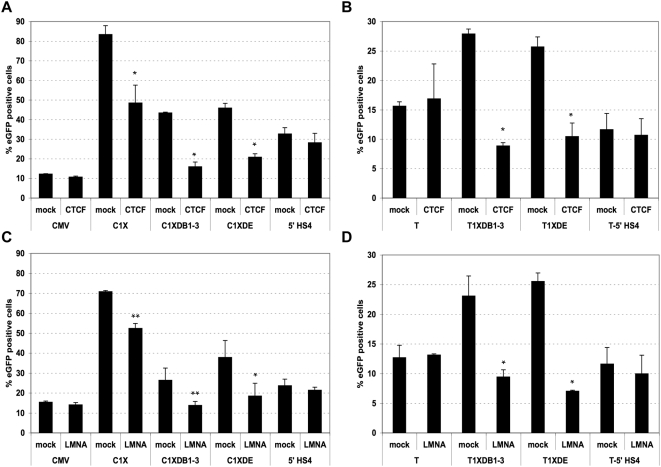
Depletion in CTCF or A-type Lamins abrogates D4Z4 anti-silencing activity.The involvement of CTCF and A-type lamins in the insulating activity of D4Z4 was studied by knocking-down their expression. A. Different populations of cells transfected with randomly integrated constructs were transfected with siRNA against CTCF (CTCF) or negative control siRNA (mock) and the level of eGFP was monitored by FACS. The mean value±S.D of three independent experiments are presented. B. Telomeric constructs harboring protection against TPE (T1XDB1-3, T1XDE) and control (T, T-5′ HS4) were transiently transfected with pools of siRNA against CTCF. The expression of the eGFP reporter gene was analyzed by FACS. C. D. The different constructs allowing the protection against CPE (C1X, C1XDB1-3, C1XDE, pCMV-5′ HS4) (panel C) or protection against TPE (T1XDB1-3, T1XDE) (panel D) were transiently transfected with siRNA against Lamins A/C and the expression of the eGFP reporter gene was measured by FACS. Asterisks denote statistically significant values relative to control siRNA (Student's t test). **p<0.01; *p<0.001.